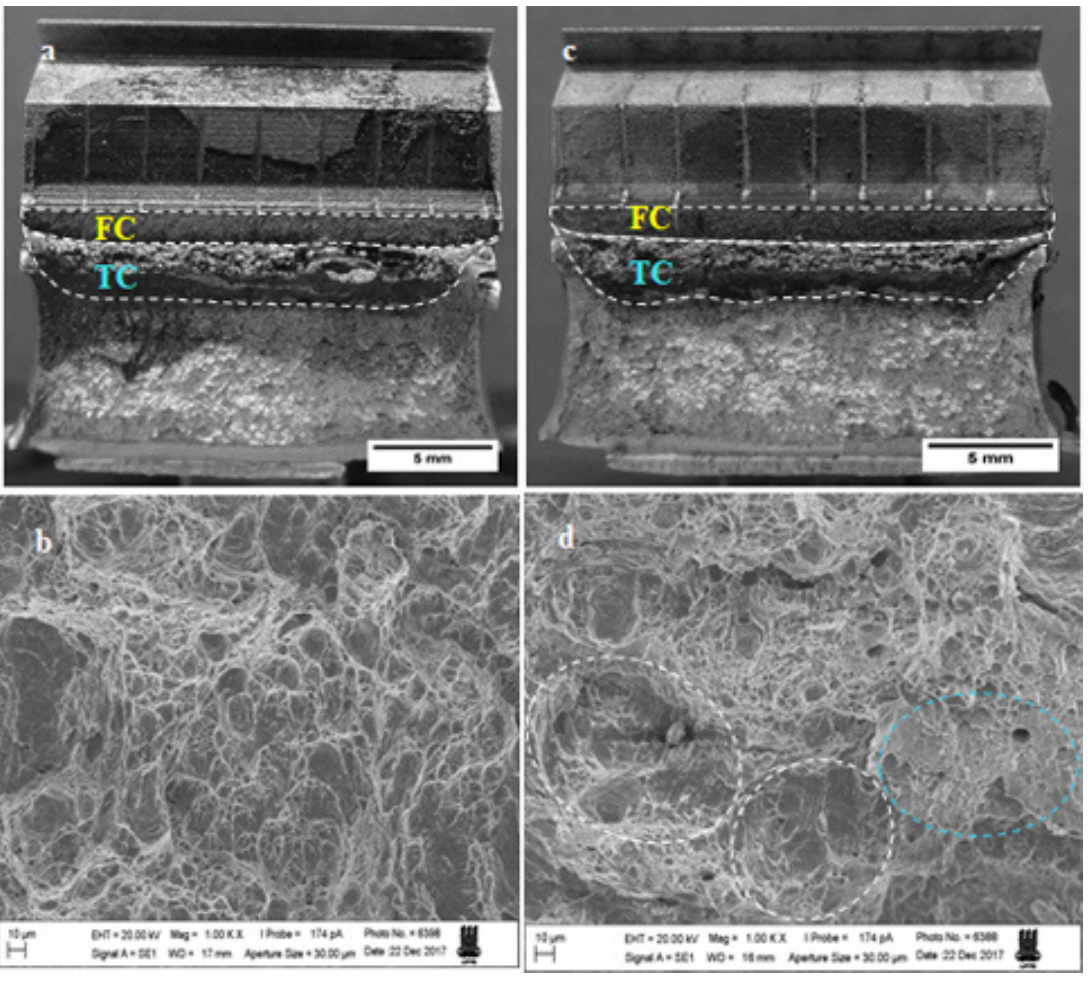
Figure 20. Fractography of the welded joint. (a) transverse surface and (b) SEM (1000x) without hydrogenation. (c) transverse surface and (d) SEM (1000x) with